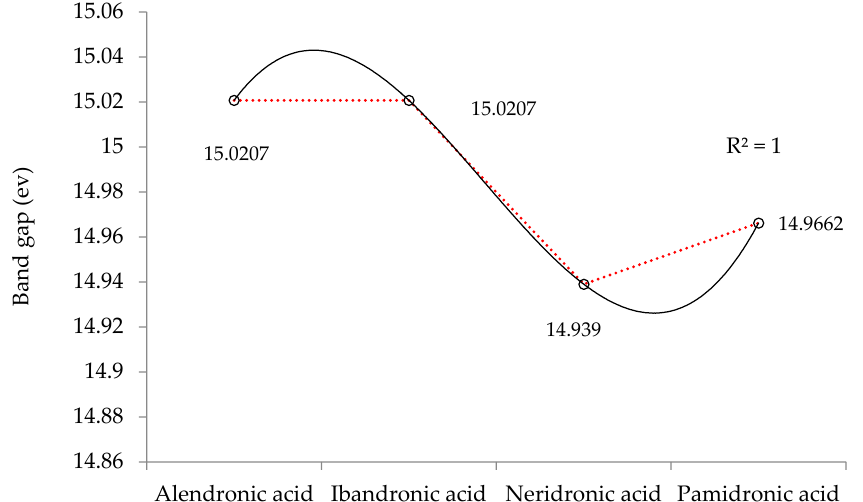
Figure 4. The band gap (ev) of HOMO-LUMO for BP-targeted alendronate, ibandronate, neridronate, and pamidronate.